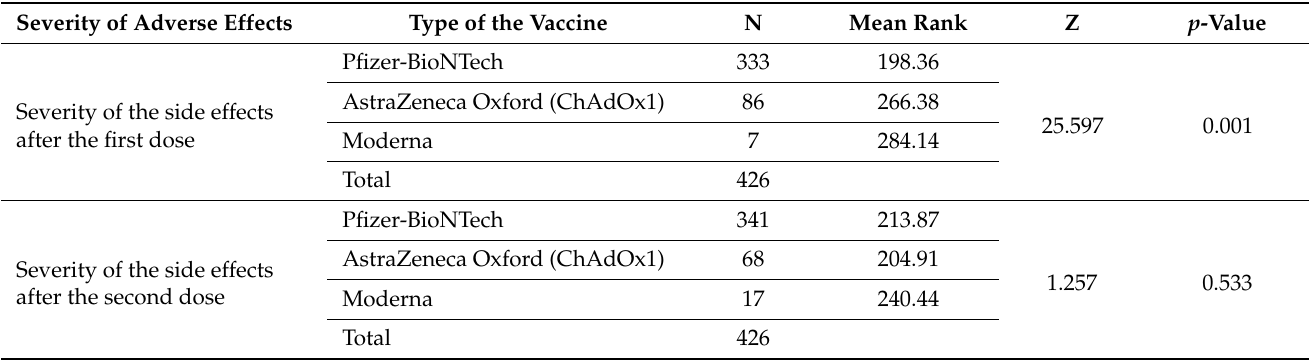
Table 6. Comparison of severity of adverse effects among the participants who received Pfizer- BioNTech, Oxford-AstraZeneca and Moderna